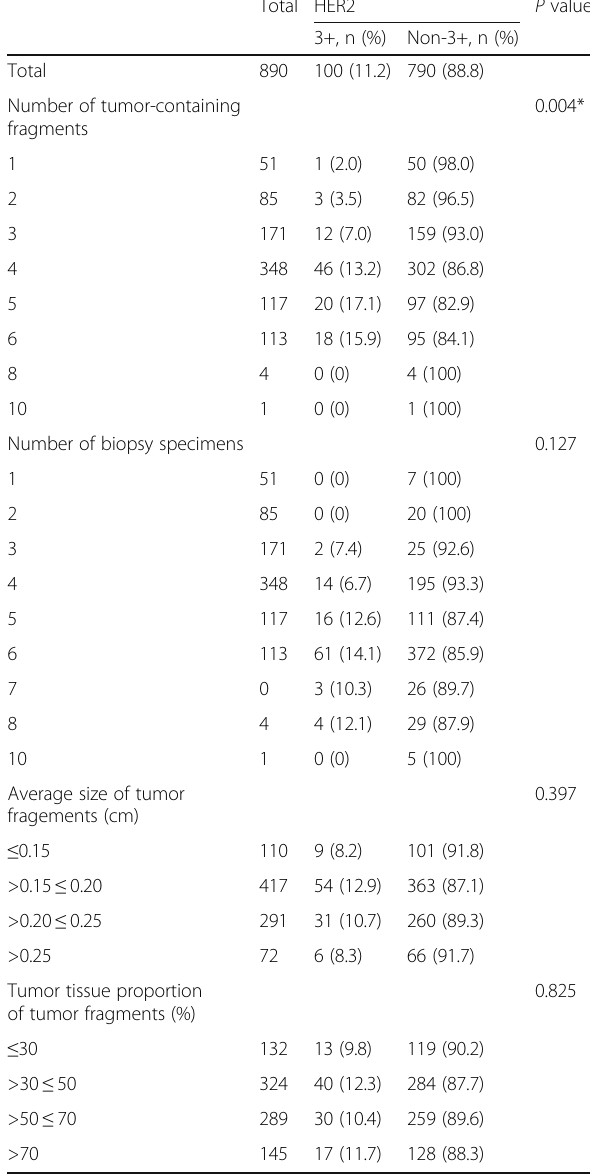
Table 4 Comparison of HER2 IHC positivity based on tumor-containing fragment number, biopsy specimen number, average size and tumor tissue proportion of tumor-containing fragments Total